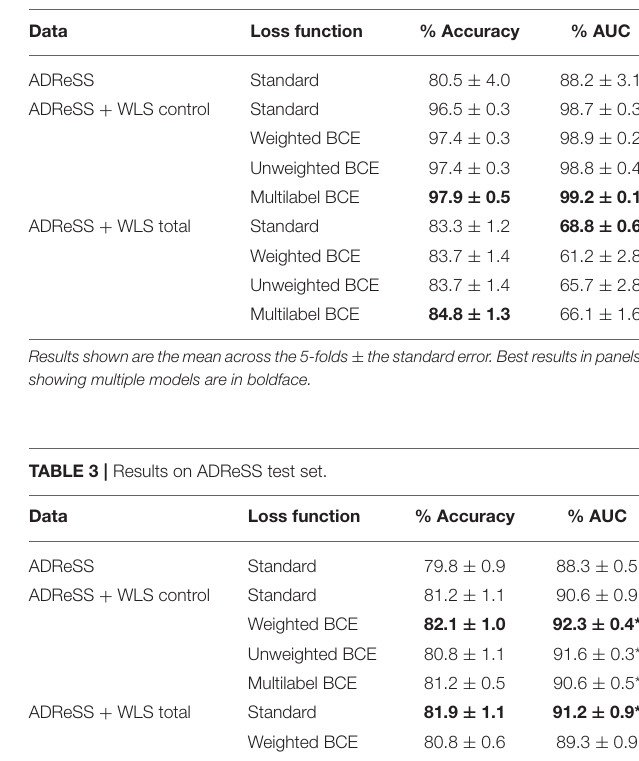
TABLE 2 | Five-fold cross-validation results on training